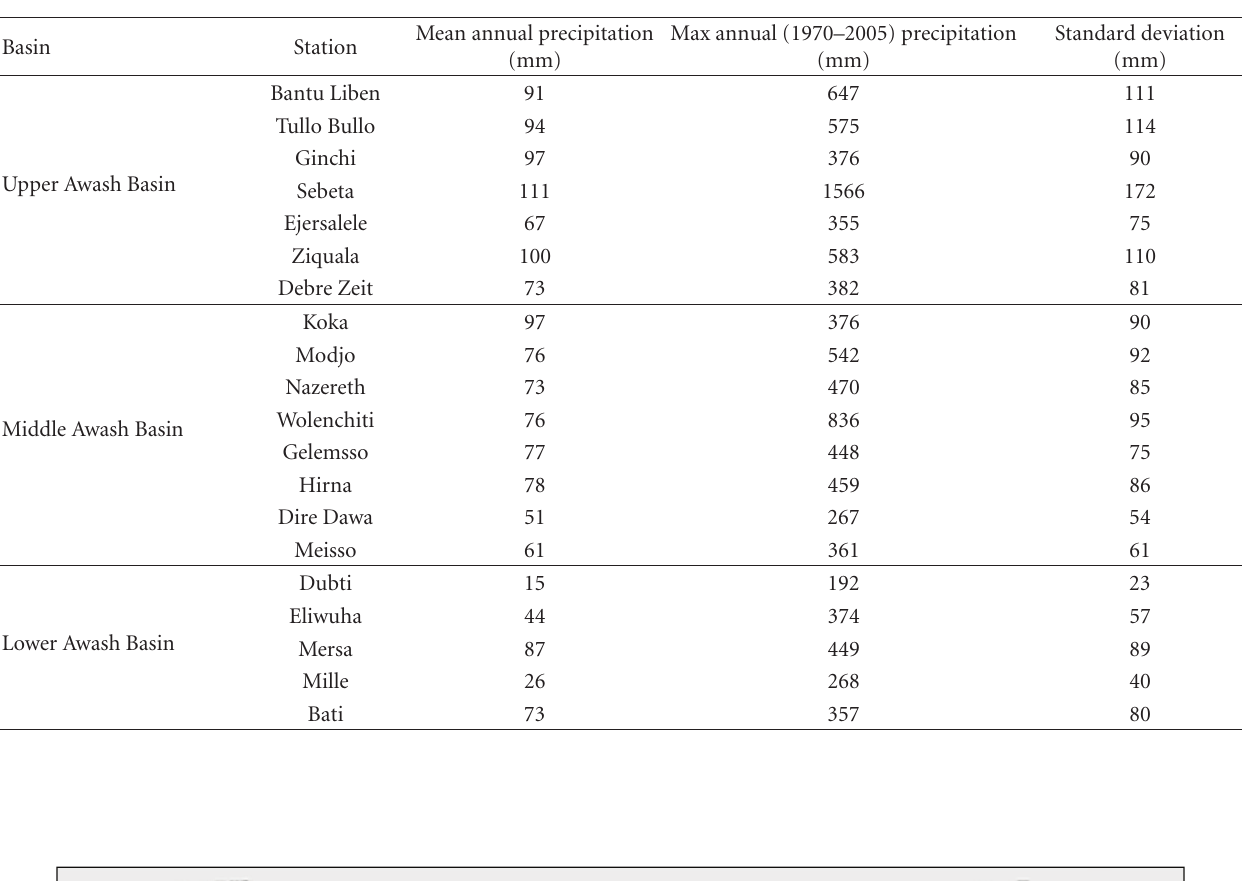
Table 2: Descriptive statistics for the Awash River Basin.